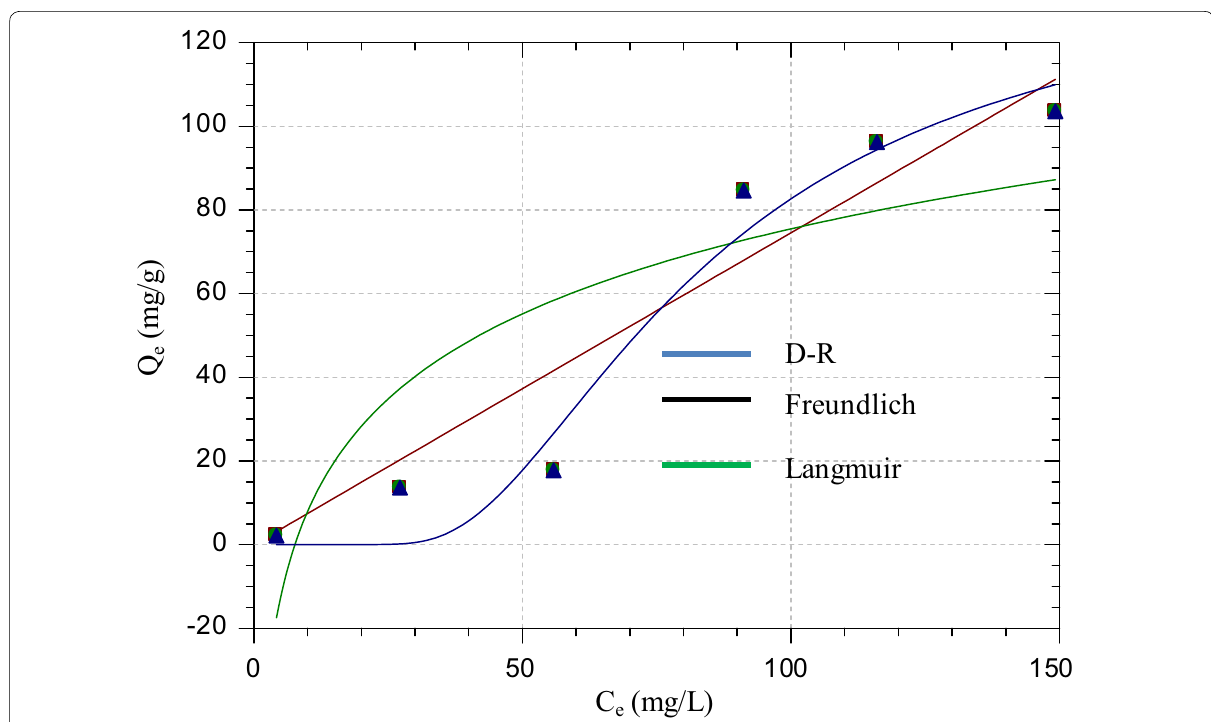
Fig. 8 Plots of Q e versus C e for Langmuir, Freundlich and D–R adsorption isotherms for the adsorption of cadmium(II) by OP at initial metal concentration of 250 mg/L, pH of 5.5 and temperature of 45 °C